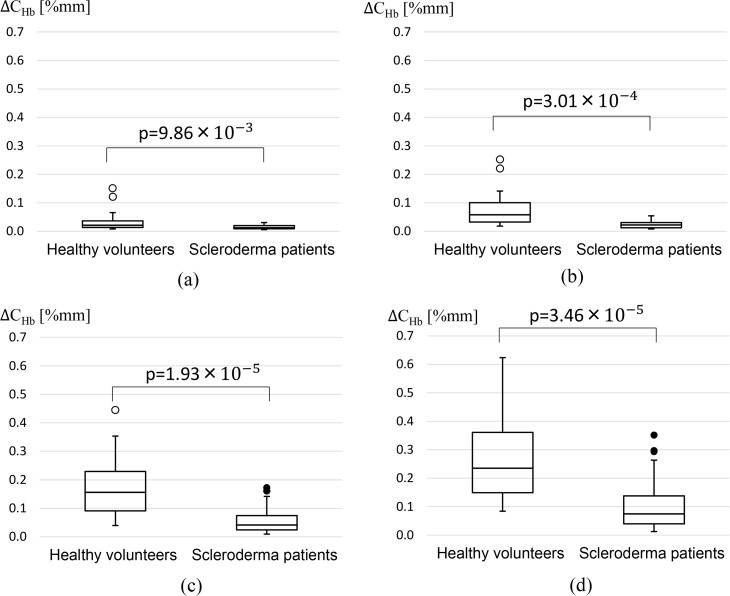
ΔCHb measured in 26 healthy volunteers and 26 scleroderma patients.(a):P2 = 88mmHg, (b):P2 = 64mmHg, (c):P2 = 40mmHg, and (d):P2 = 28mmHg.